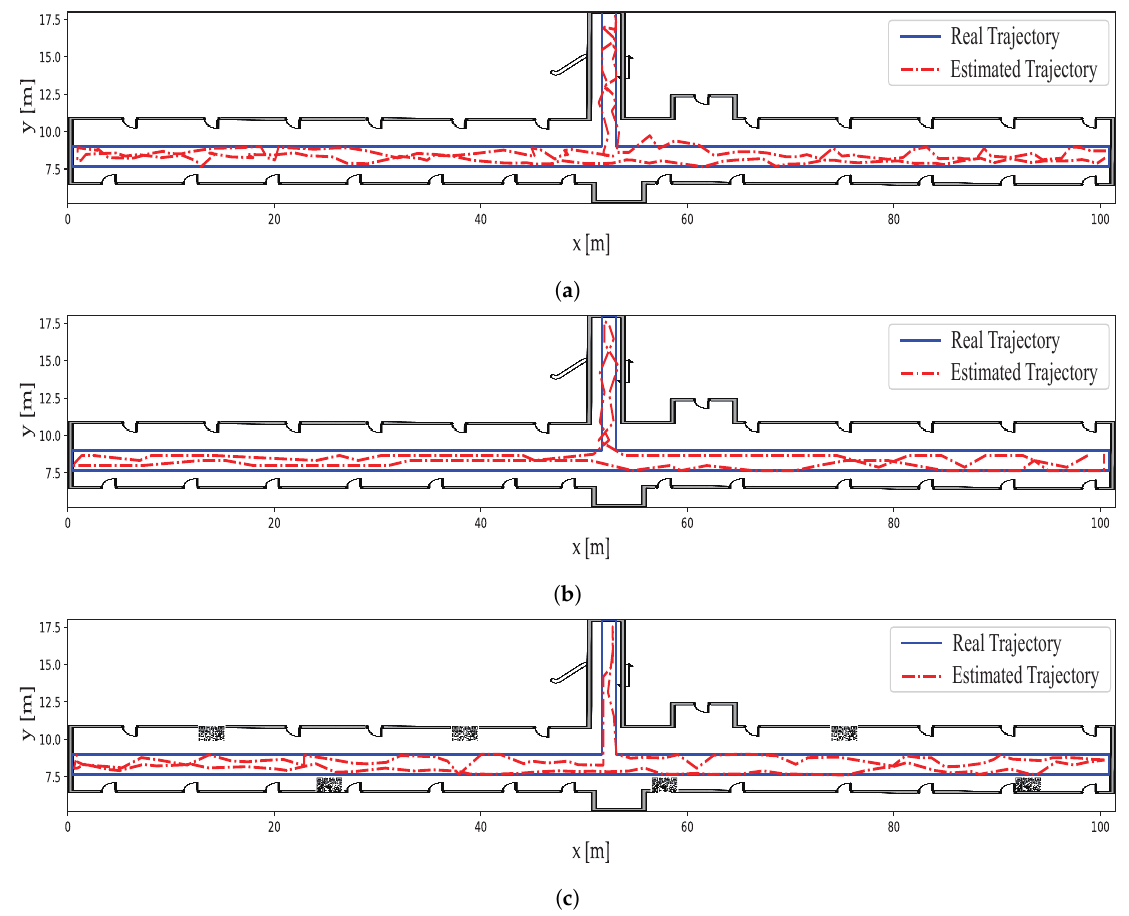
Figure 14. Estimation of moving trajectory in the corridor. ( a ) Moving trajectory of user measured with App. 1. ( b ) Moving trajectory of user measured with App. 2. ( c ) Moving trajectory of user measured with App.